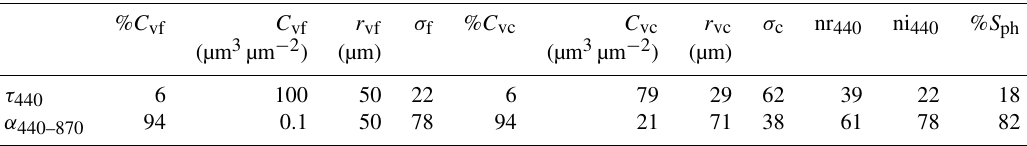
Table 3. Percentage of occurrence for the aerosol optical thickness τ 440 and the Ångström coefficient α 440–870 as giving the regression coefficient for each microphysical